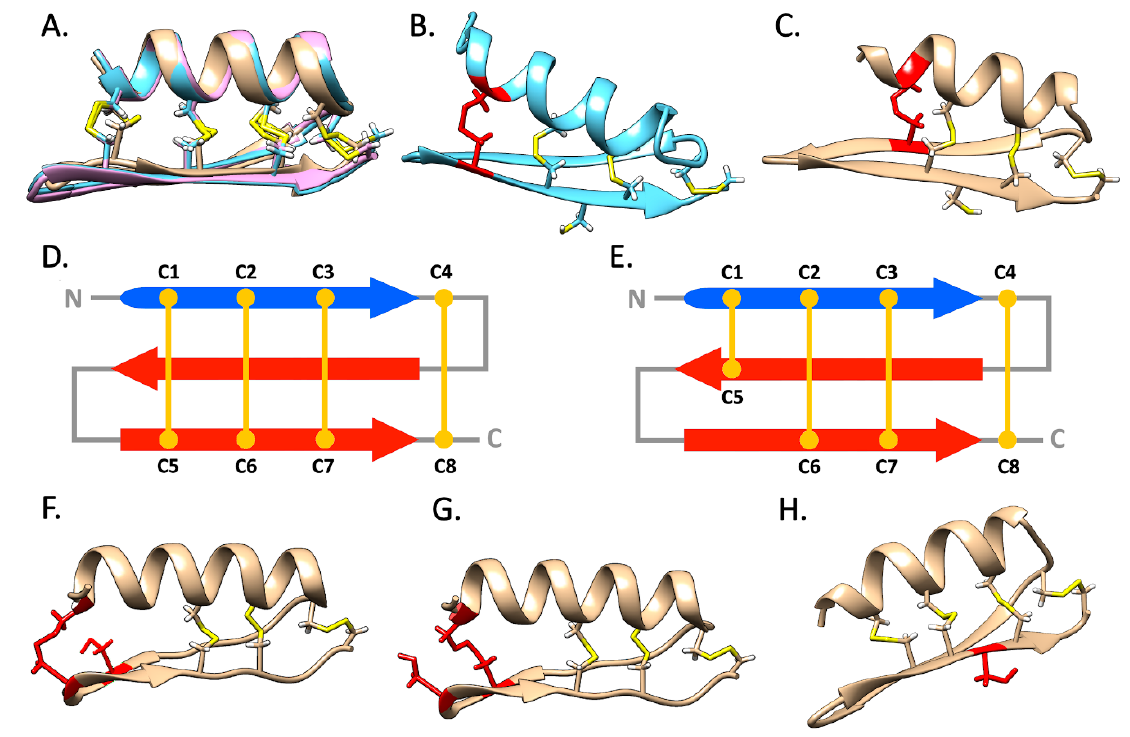
Figure 6. Panel A : super-imposition of the structural models obtained for T. hirsuta mytilin 1, 2 and 3. Panels B and C : structural models of Perna mytilins characterized by the presence of a canonical and an alternative cysteine array, respectively; the variable position of the C1–C5 disulfide bond is highlighted in red. Panels D and E schematic organization of the disulfide bond topology of mytilins with a canonical and alternative cysteine array, respectively. Panels F and G : alternative structural variants for M. galloprovincialis mytilin K, with two different sterically allowed C1–C5 disulfide bonds, highlighted in red. Panel H : structural model of a Perna defensin, with the side chain of the central cysteine residue of the CCC motif pointing outwards, highlighted in red.